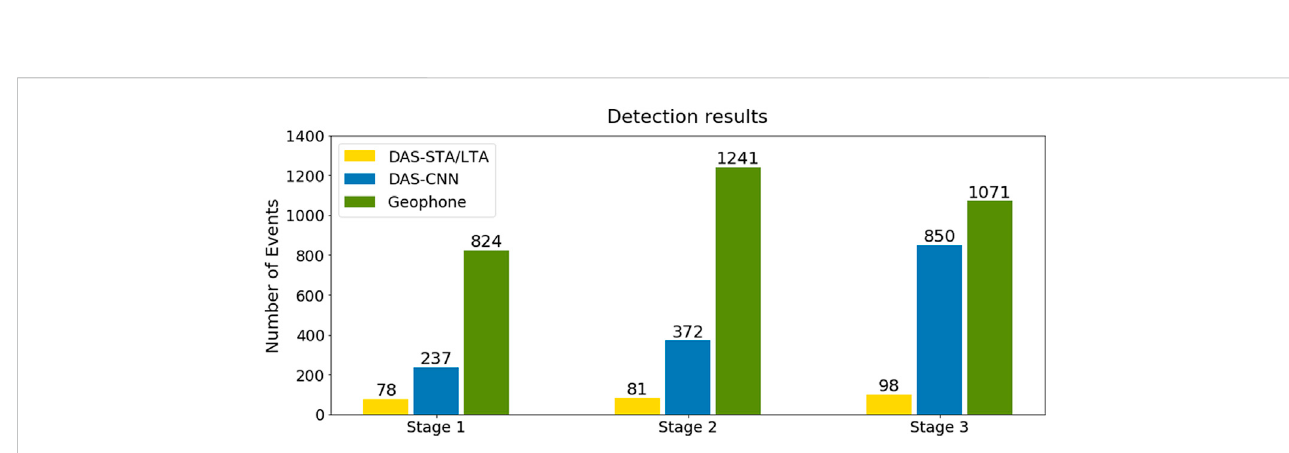
FIGURE 10 Case study 2: Event detection results of three stages in the second DAS data, comparing performance of DAS STA/LTA (yellow), CNN (blue), and 3C geophone